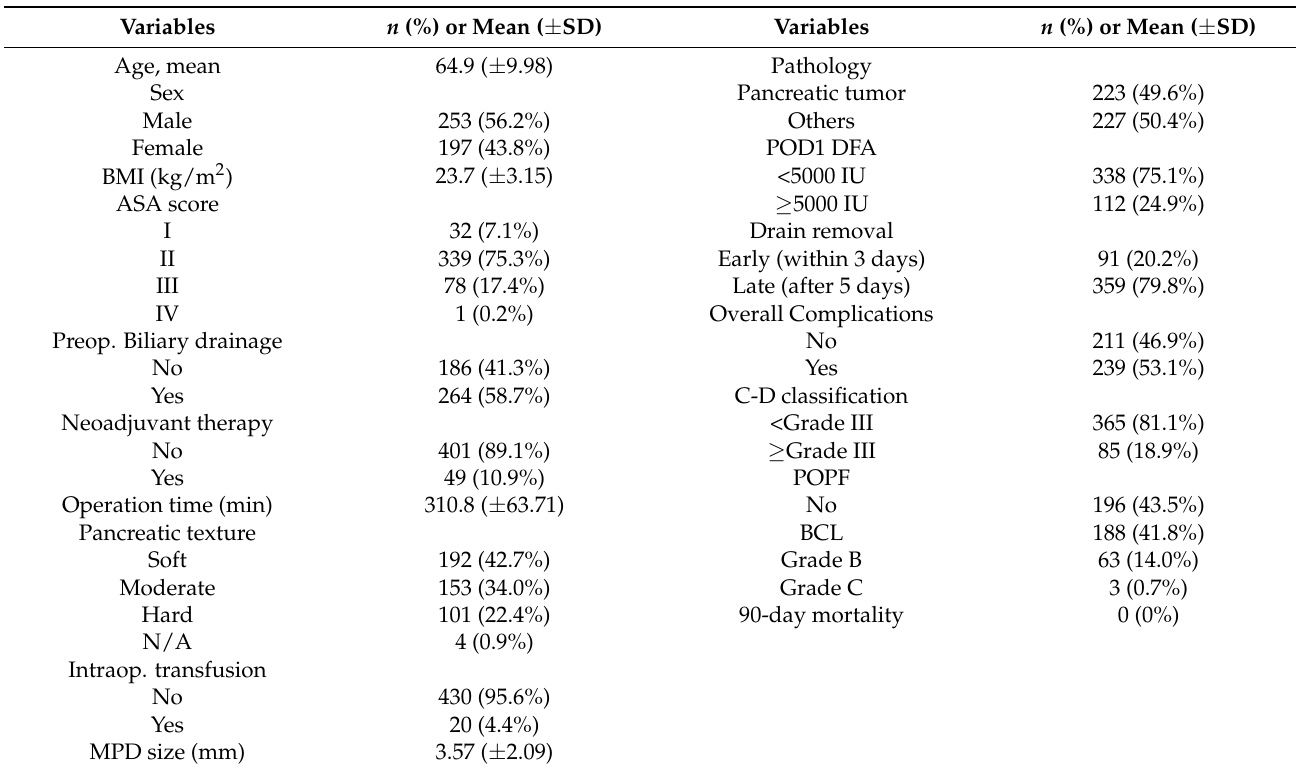
Table 1. Demographics and clinical characteristics, all patients ( n =